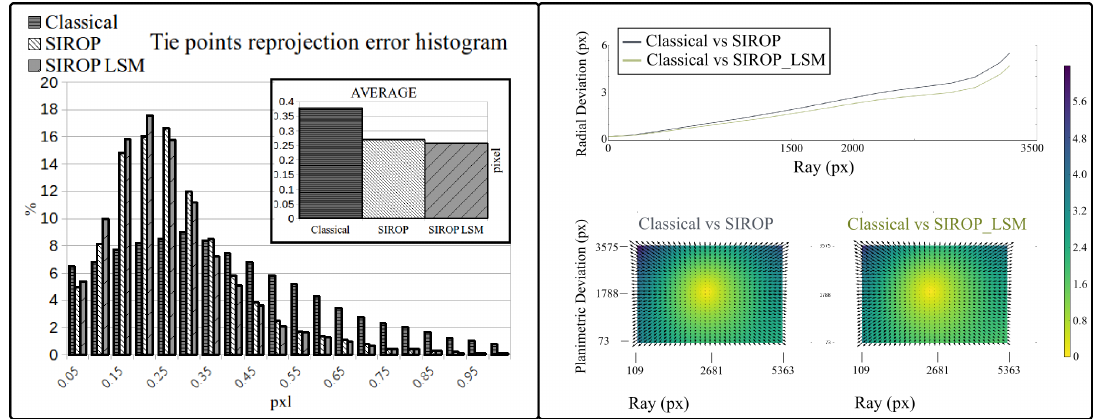
Figure 17. The evaluation of LSM efficient on SIROP tie-point. ( Left ): reprojection error histogram. ( Right ): difference in camera calibration with LSM refinement.